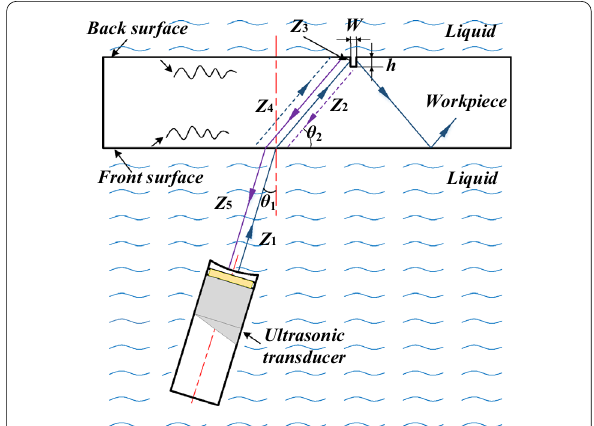
Figure 2 Ultrasonic immersion testing model with rough surface for change (e.g., become rough). The echo response of a